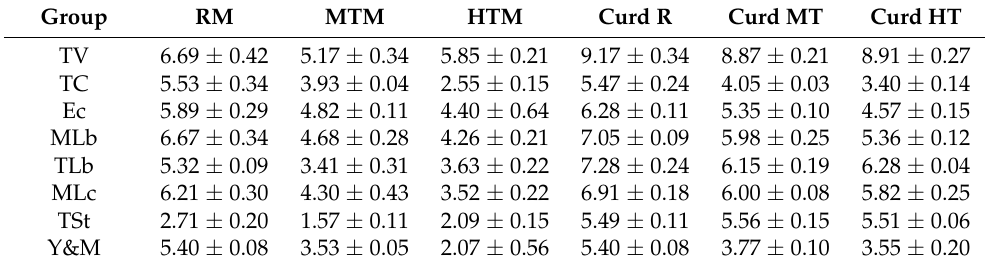
Table 2. Counts * of the major microorganism groups (cfu/g) in the vat milk (after starter addition) and in the curd. RM = raw milk; MTM = mild-thermized milk; HTM = high-thermized milk. TV = total viable; TC = total coliforms; Ec = enterococci; MLb = mesophilic lactobacilli; TLb = thermophilic lactobacilli; MLc = mesophilic lactococci; TSt = thermophilic streptococci; Y&M = yeasts and molds. Mean values ± standard deviation from two analyses on each type of milk and